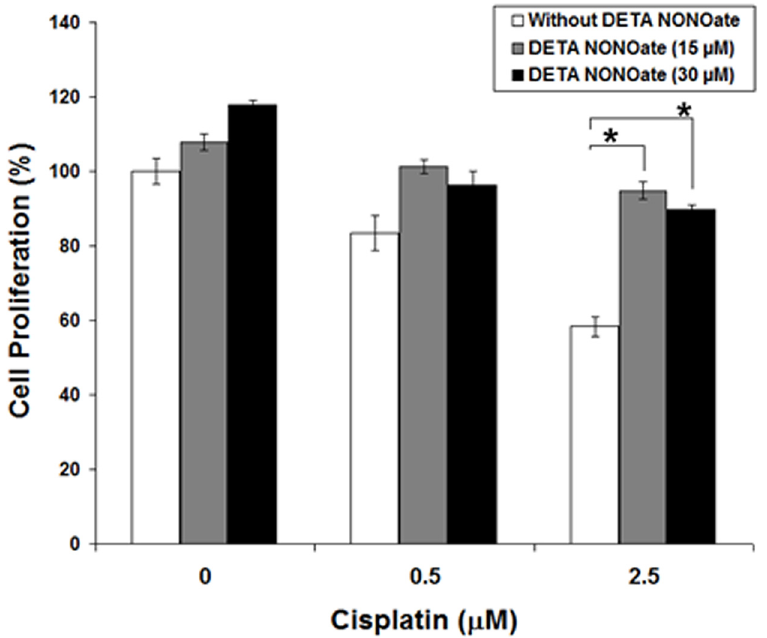
Fig 7. The presence of DETA NONOate reverse the inhibitory effect of cisplatin on MDA-MB-231 cells. Asterisk indicates p < 0.01.